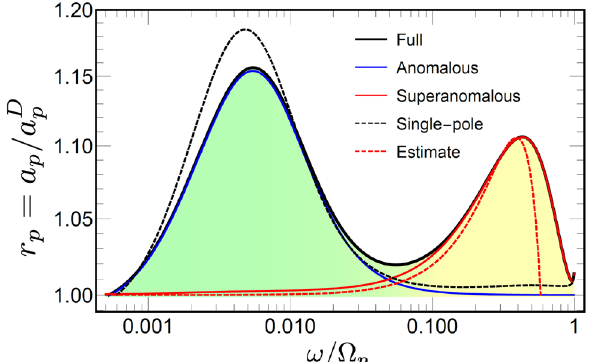
a p / a D a D Figure 3. Relative absorptivity r p p , where p is obtained for the Drude model. The black line = ”Full” gives a p , calculated for the full model in Eqs. (2), the solid blue line ”Anomalous” and the red line ”Superanomalous” give a p obtained using A and S approximations in Eqs. (9) and (10), respectively. The dotted black line ”Single-pole” gives a p obtained using the single-pole approximation in Eq. (11). Red dashed line ”Estimate” give the estimation for a p given by Eq. (17). The colour filling corresponds to the ASE and SASE 50 frequency ranges. The incident angle is θ ◦ . =